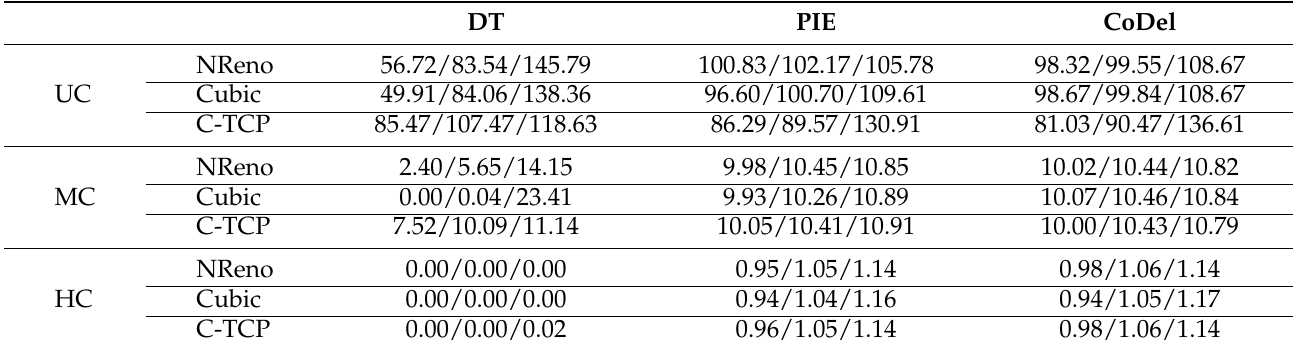
Table 2. Quartiles of flows’ throughput [Mbps] in the Data center scenario with common TCPs, UC—uncongested, MC—mildly congested, HC—heavily congested network.